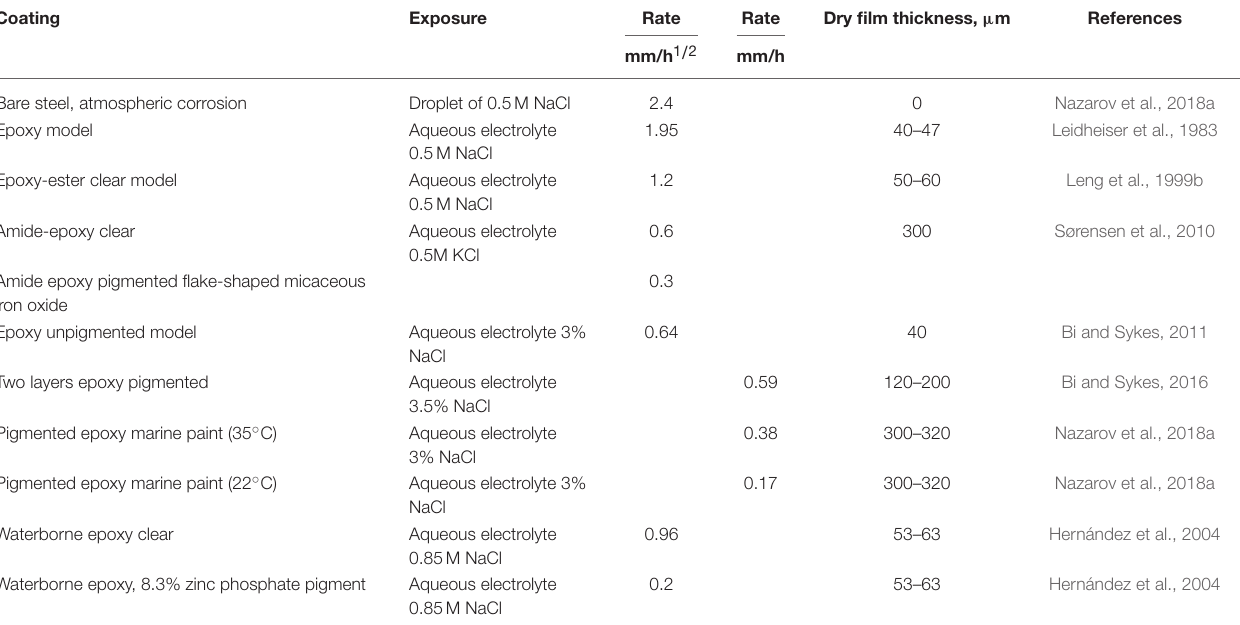
TABLE 1 | Rates of cathodic deadhesion (spreading) for square root or linear kinetics during exposure in aqueous electrolytes, type of coating, and pigment, exposure conditions, coating thickness.